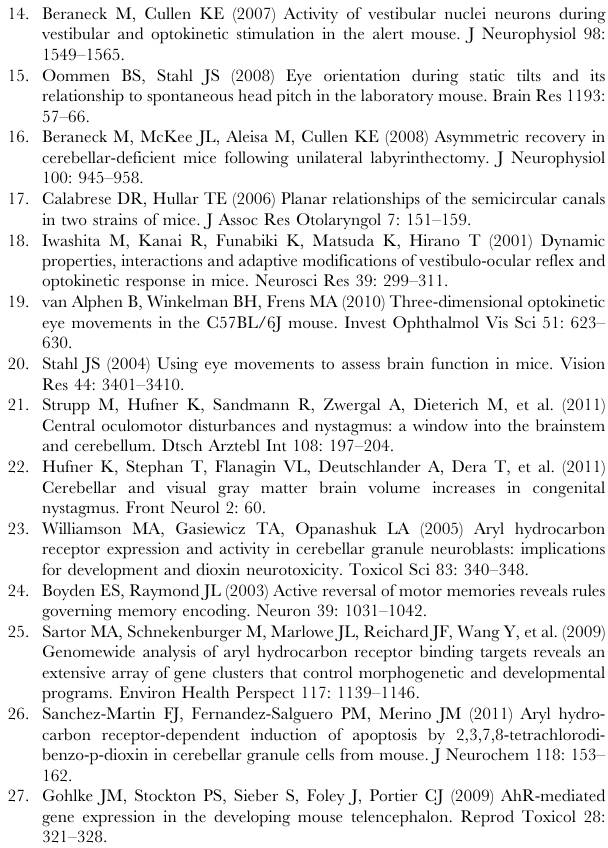
Figure S1 Evolution of the nystagmus throughout mice aging. Position of the eyes in the horizontal plan (EHP) of two AhR 2 / 2 mice at different ages (10 and 23 weeks for mice 1; 24 and 38 for mice 2). The figure presents discontinuous time, as indicated by the vertical lines. EHP, Eye Horizontal position. (TIF) Figure S2 TCDD treatment of adult AhR + / + mice did not affect gaze stability. Adult AhR + / + mice were treated by 25 m g/kg of TCDD at day 0, 7, 14, 21, 28. The mice were monitored at day 0, 13, 27, 34 (respectively D0, D13, D27, D34). Positions of the eyes in horizontal (EHp) plan in the absence of head movements in the dark are presented. The AhR + / + mice treated by TCDD did not exhibit a horizontal pendular nystagmus. Note D13 trace shows discontinuous time, as indicated by the vertical line. EHp, Eye Horizontal position.